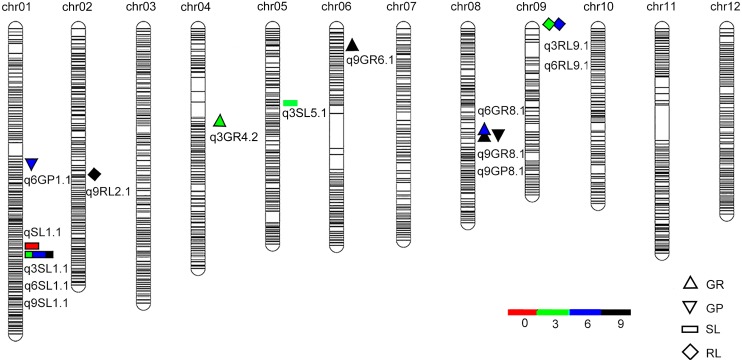
QTLs for seed vigor for artificial aging treatments detected in Oryza longistaminata BIL population. QTLs for seed vigor related traits (germination potential, germination rate, seedling length, and root length) under artificial aging treatments. Red, artificial aging for 0 day; Blue, artificial aging for 3 days; Green, artificial aging for 6 days; Dark Black, artificial aging for 9 days.